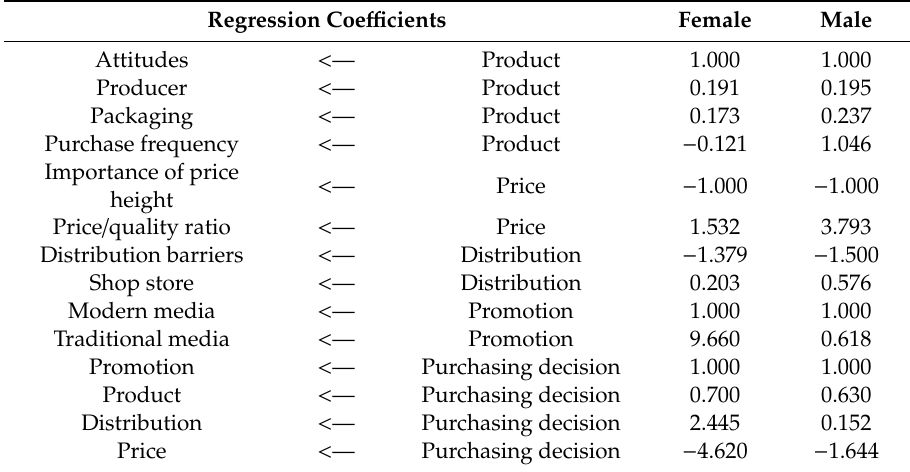
Table 4. Estimated results of the structural equation model (SEM) for women and